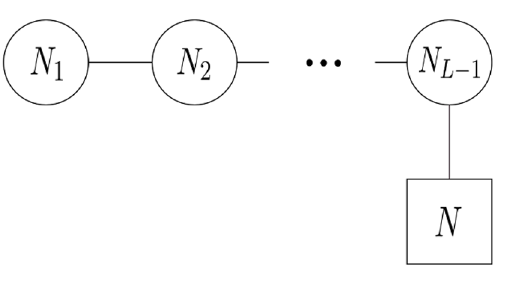
Figure 1 . The quiver diagram for the T (cid:26) [SU( N )] quiver